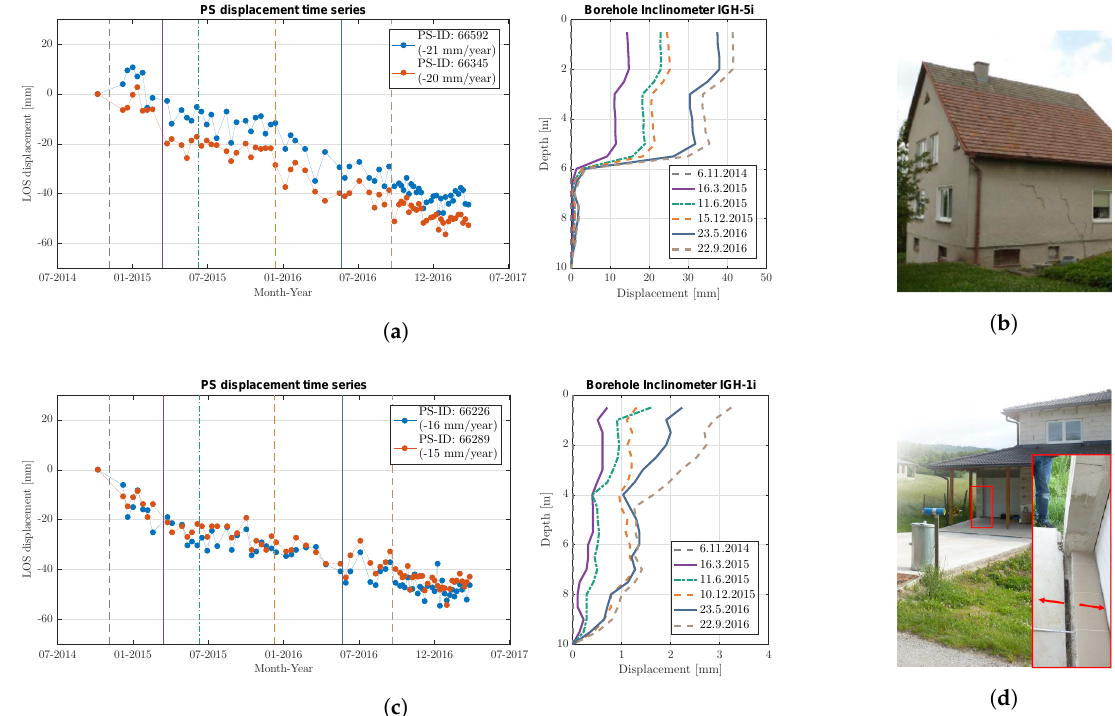
Figure 11. ( a ); ( c ) Comparison of InSAR derived LOS displacement time series (from descending track) with borehole inclinometer measurements at points IGH-5i (depth of shear zone: 4.61 m, mean displacement velocity: 18.9 mm/year, orientation: northwest-west) and IGH-1i (expected depth of shear zone: 3.44 m, mean displacement velocity: 1.2 mm/year, orientation: southwest), adjacent to ( b ); ( d ) disrupted